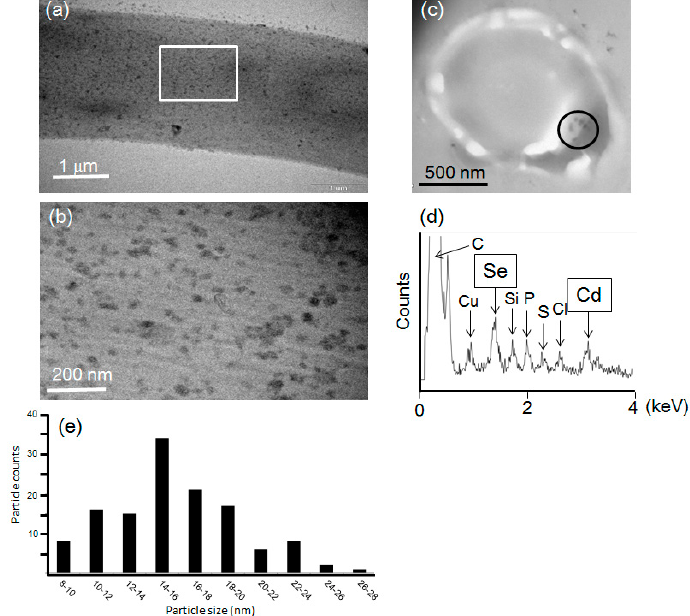
Figure 6. ( a ) Transmission Electron Microscopy (TEM) observation of the mycelial cells of F. oxysporum after treatment of a 5 mM Cd (+) Se IV (+) solution (pH 7.5) at 25 °C . The white rectangle region was magnified in ( b ); ( b ) The magnification image of the white rectangle region in ( a ); ( c ) The ultra-thin cross-section of the mycelial cells of F. oxysporum after treatment of a 5 mM Cd (+) Se IV (+) solution (pH 7.5) at 25 °C observed by TEM. The black circled region was analyzed by energy-dispersive spectrometer (EDS); ( d ) The EDS spectrum from the black circled region in ( c ); ( e ) The size distribution of nanoparticles in the image of ( b ).